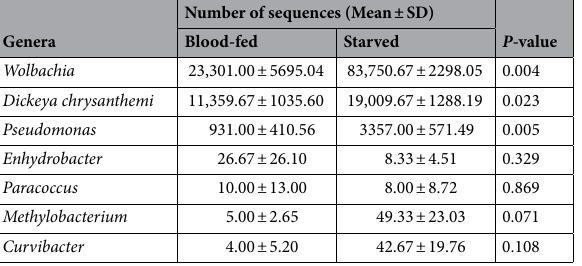
Table 3. The number of sequences between blood-fed and starved bed bugs with P -value determined using paired samples T-test.